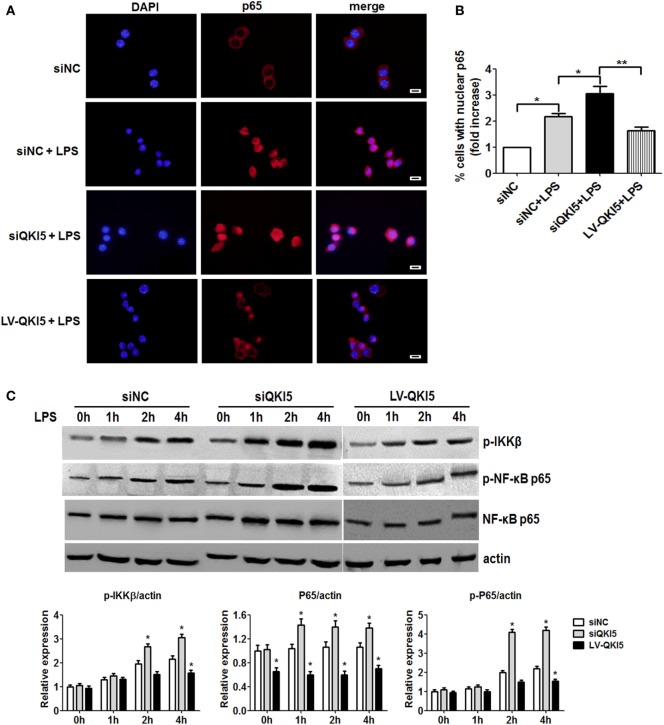
Lack of quaking (QKI)-enhanced lipopolysaccharide (LPS)-induced nuclear translocation and phosphorylation of NF-κB. (A) QKI-silenced or overexpressed RAW 264.7 cells were treated with 1 µg/ml LPS for 2 h. Immunostaining for p65 (red) was performed. DAPI staining is shown in blue. Scale bar, 20 µm. (B) Graphs show the percentage of macrophages with nuclear p65 (fold increase) in (A). Briefly, 100 randomly chosen cells were counted and categorized into two groups according to the subcellular distribution of p65, including nuclear or cytoplasmic. (C) QKI-silenced or overexpressed RAW 264.7 cells were treated with 1 µg/ml LPS for the time indicated. One representative western blot of phospho-IKKβ, phospho-NF-κB p65, and total NF-κB p65 is shown. All the bars represent the mean of measurements from three independent experiments, and the error bars indicate ±SEM. *p < 0.05, **p < 0.01 versus siNC control.